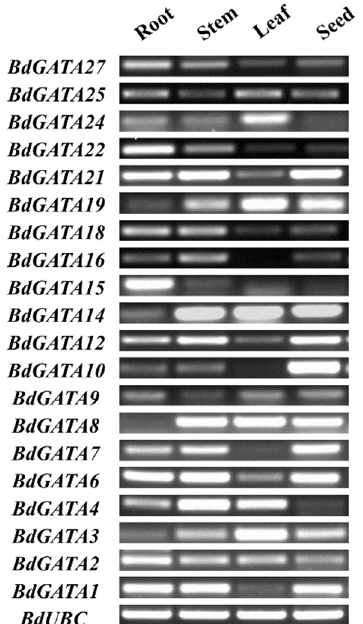
Figure 7. Expression profiles of BdGATA genes with phytohormone treatments. ( A ) Fold change in expression of BdGATA genes after hormone treatments. Fold change in BdGATA gene expression after hormone treatments assessed by qRT- PCR of cDNA isolated from hormone treatment plants were compared with mock treatment plants. Fold change of 1 means no difference in gene expression between hormone treatment plants and mock treatment plants. This assay was repeated three times with similar results. ( B ) Box–whisker plot of BdGATA gene expression after phytohormone treat- ments. The y -axis represents relative gene expression level. Whiskers represent maximum/minimum values, boxes indi- cate the first quartile and third quartile, and the horizontal line represents the median.